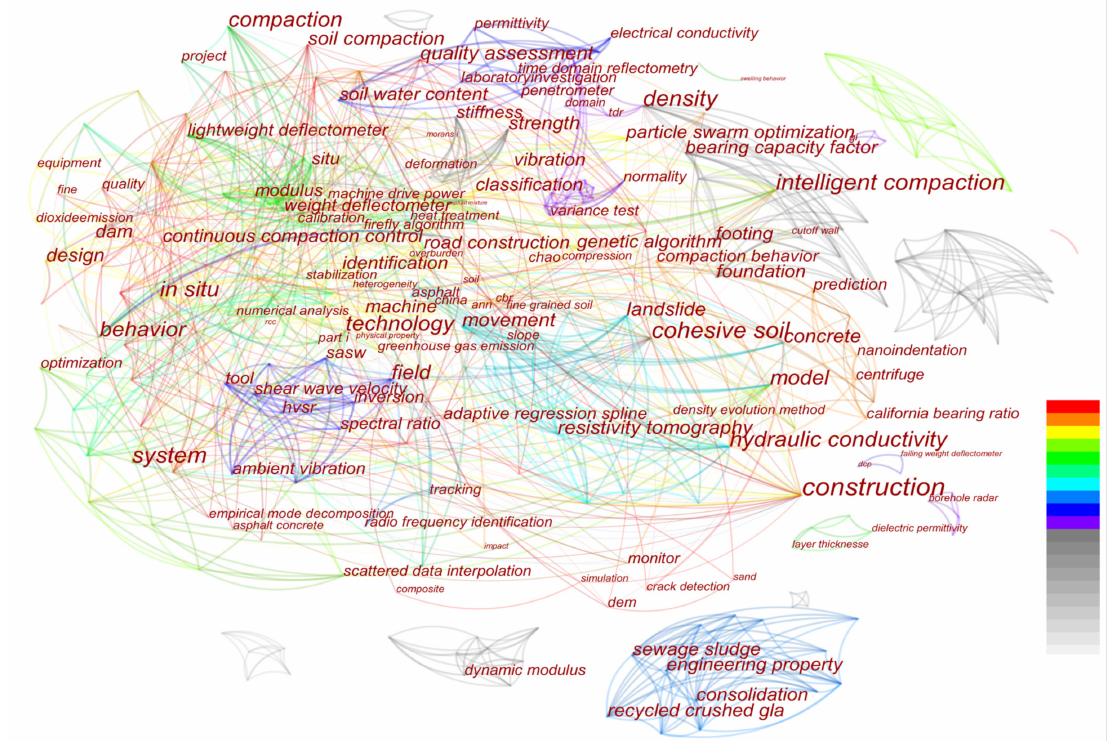
Figure 1. Keyword